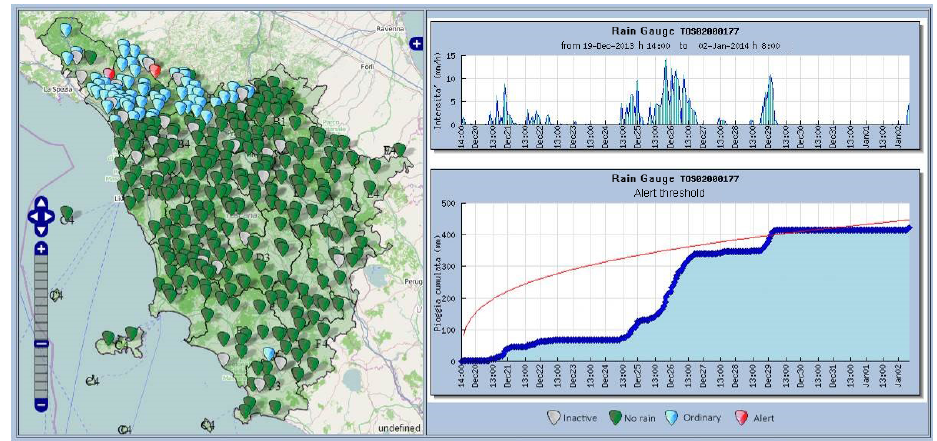
Figure 8. Evolution of the rainfall event that struck in northern Tuscany on December